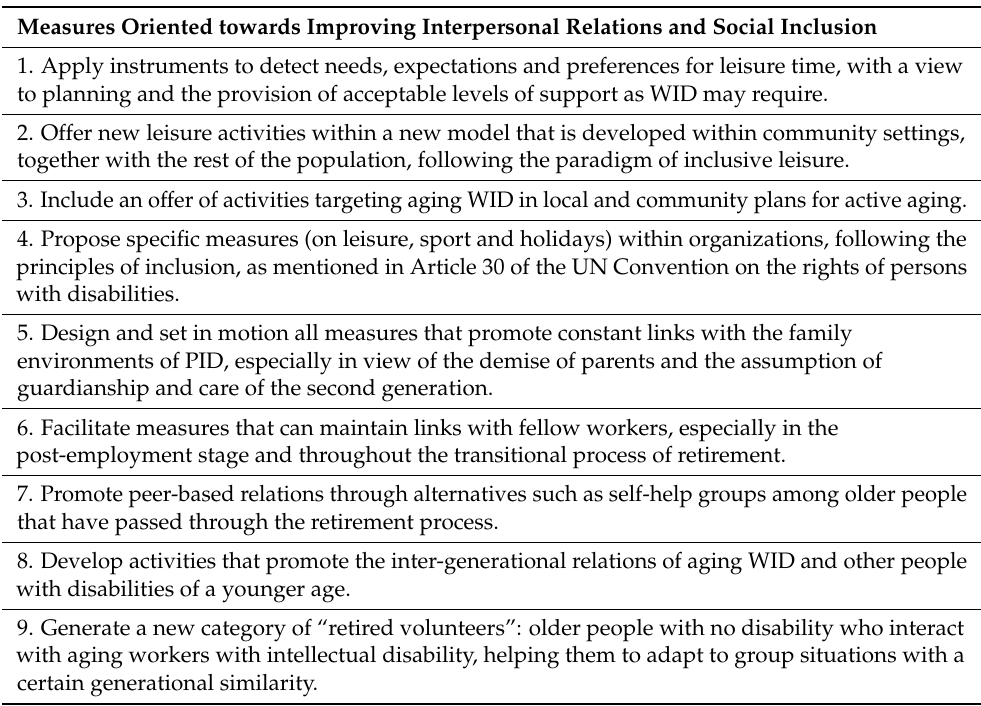
Table 5. Line of action 2, referring to social